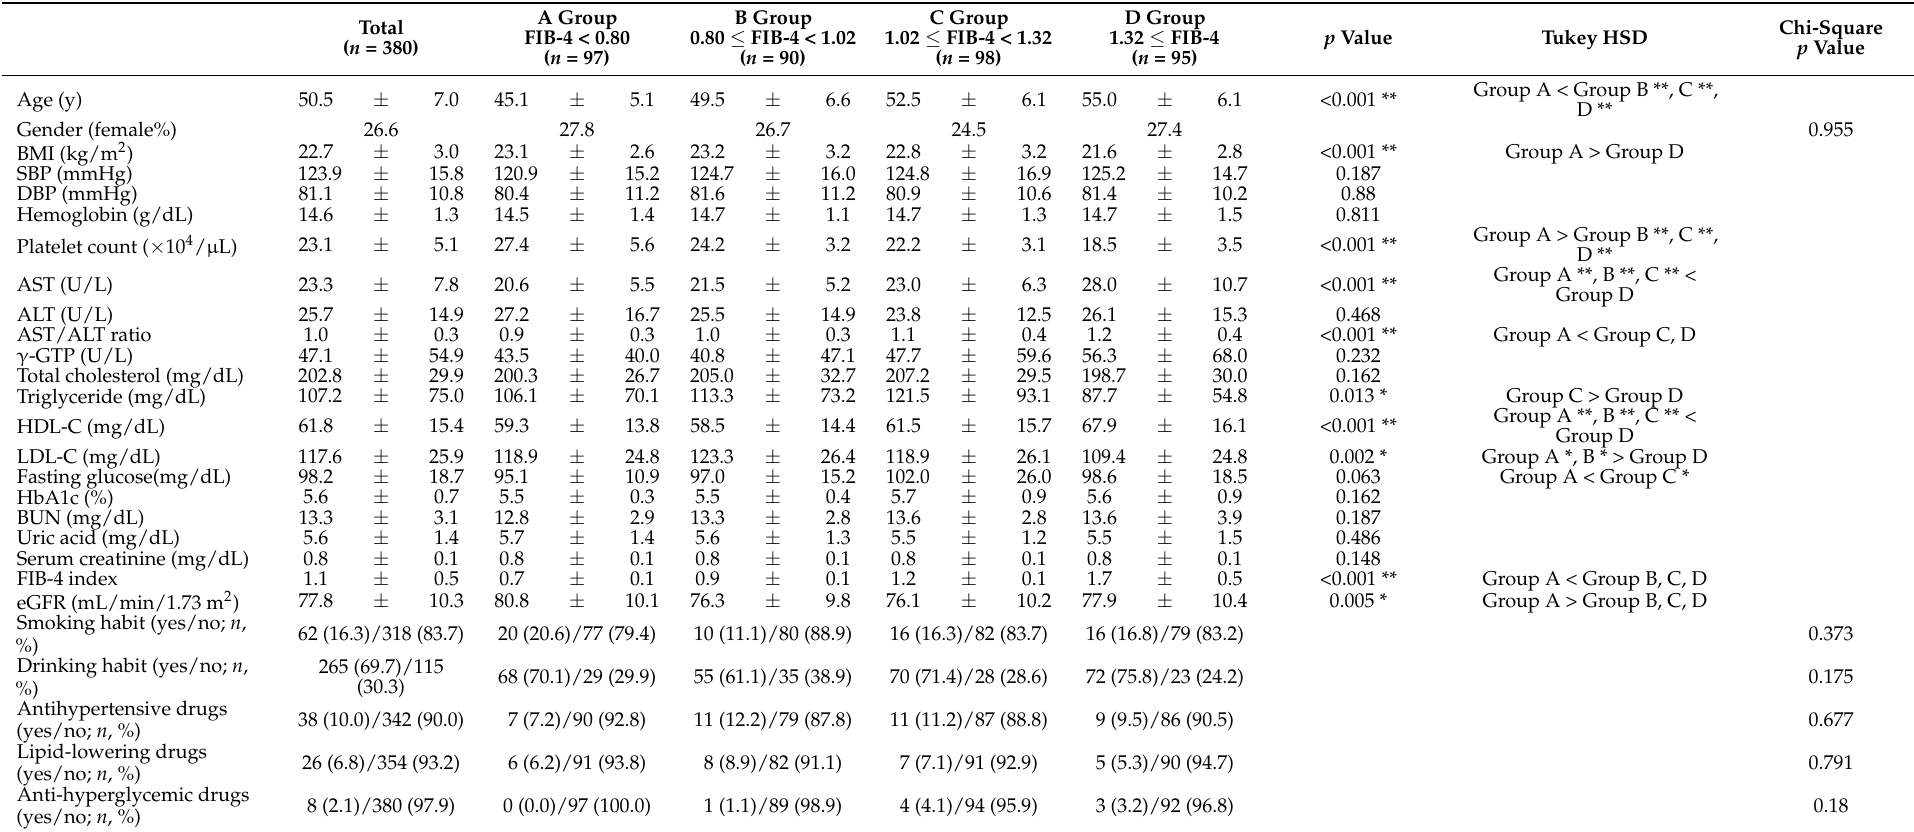
Table 3. The characteristics of subjects in Study 2